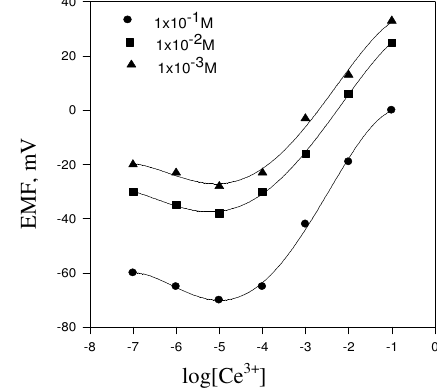
Figure 2. Effect of internal solution on potential response of the Ce(III)-selective electrode based on